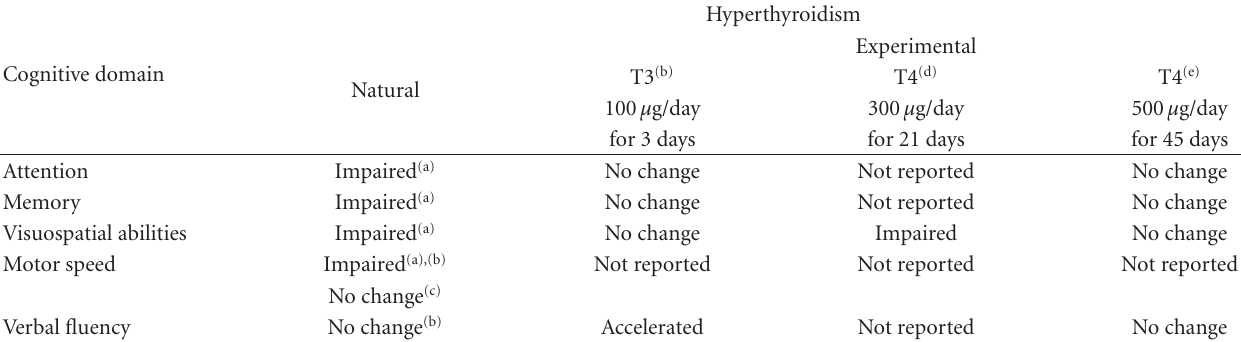
Table 5: Cognitive changes in (natural and experimental)